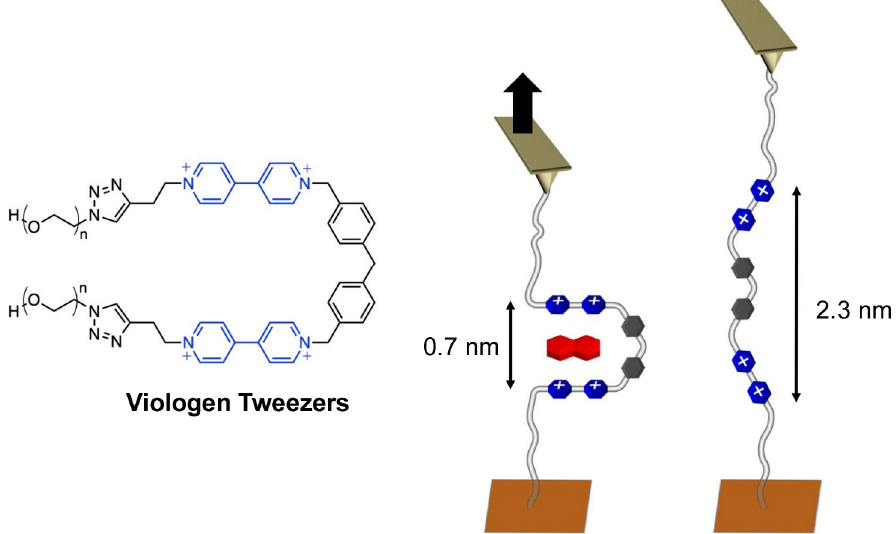
Figure 2. Viologen tweezers sandwiched between the AFM tip and a mica substrate for quantification of the force of various weak noncovalent interactions produced by molecular machines at the single molecule level. Reprinted with permission from Reference [124]. Copyright 2020 American Chemical Society.